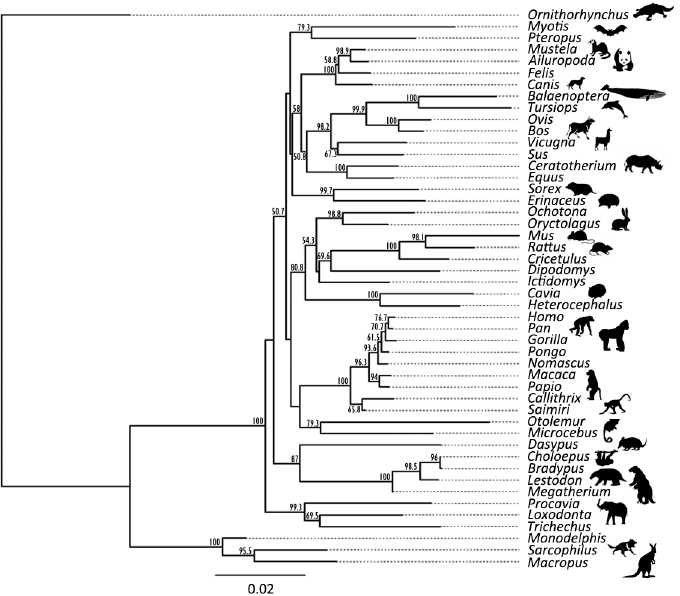
Fig 2. Maximum Likelihood analysis of the concatenated COL1A1 and COL1A2 sequences of eutherian mammals including the proposed consensus sequences of the two extinct ground sloths Lestodon and Megatherium